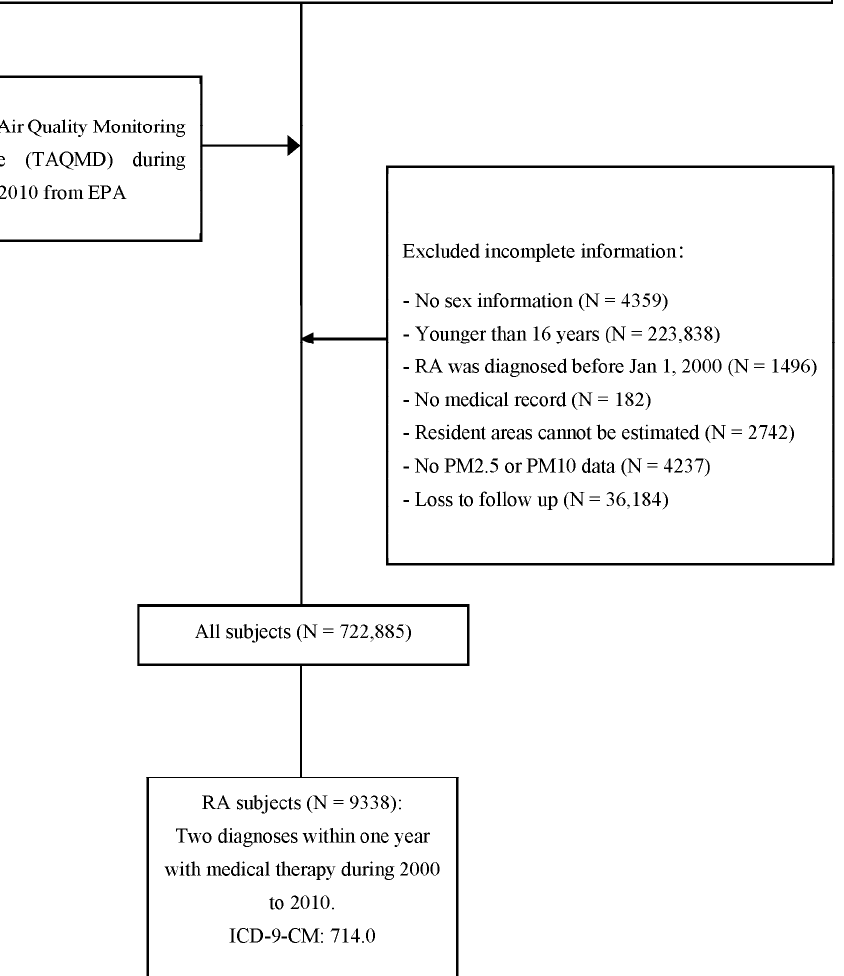
Figure 1. The flow chart shows the recruitment of eligible newly RA cases from 1 million beneficiaries, excluding incomplete information from 2000 to 2010, and merged Taiwan Air Quality Monitoring Database (TAQMD) files with a longitudinal cohort study.